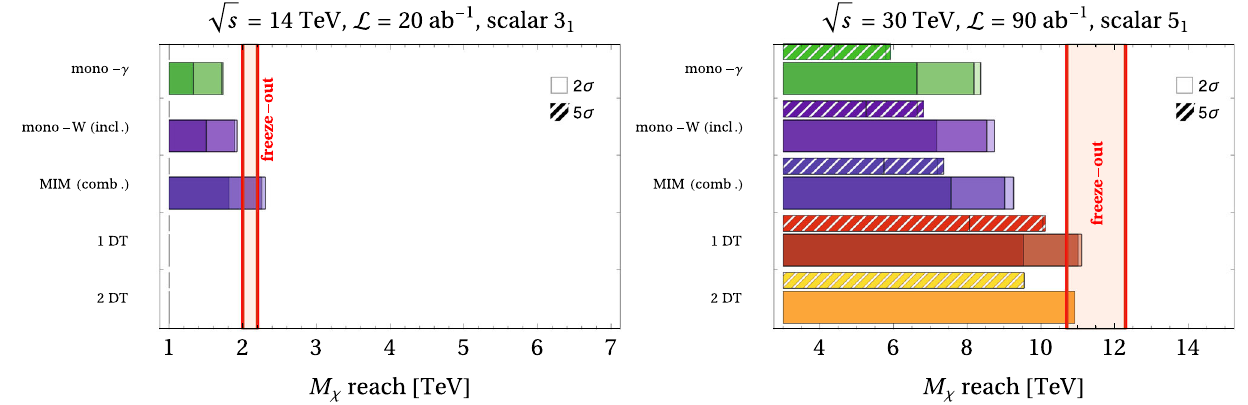
Fig. 10 Results for scalar WIMPs. Same notation as in Fig.